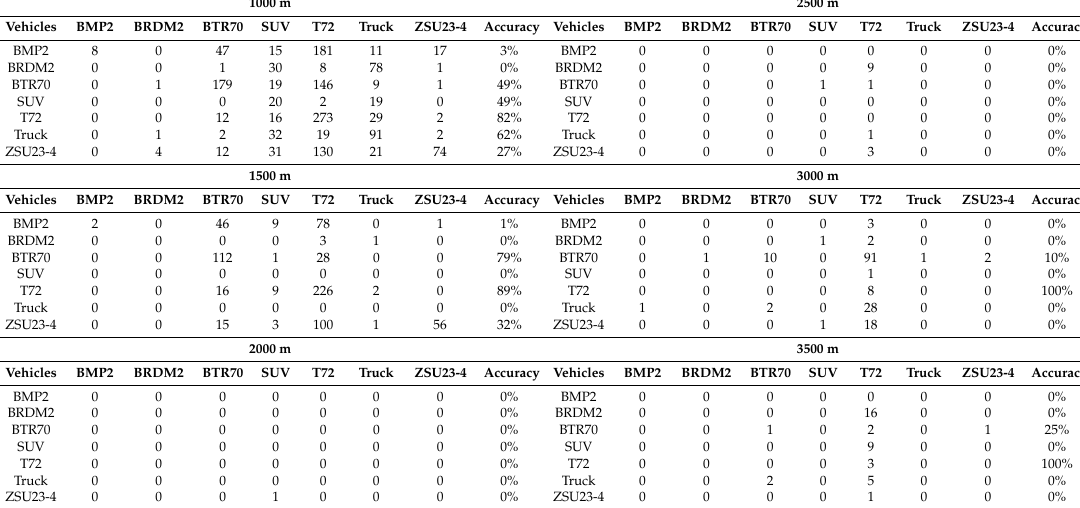
Table A4. Classification results for PCE 25 (optical video) case. Left shows the confusion matrix and the last column shows the classification accuracy.